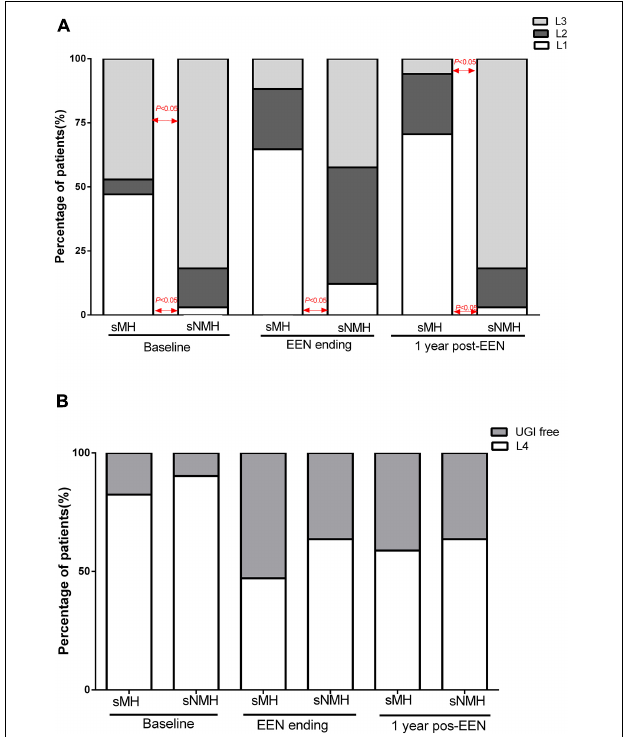
FIGURE 2 | The Paris Classifications in the two groups of patients from baseline to 1-year post-EEN. (A) L1, L2, and L3 at each time point in the two groups of patients. (B) L4 at each time point in the two groups of patients. Abbreviations: EEN, exclusive enteral nutrition; sMH, sustained mucosal healing; sNMH, sustained non-mucosal healing; UGI, upper